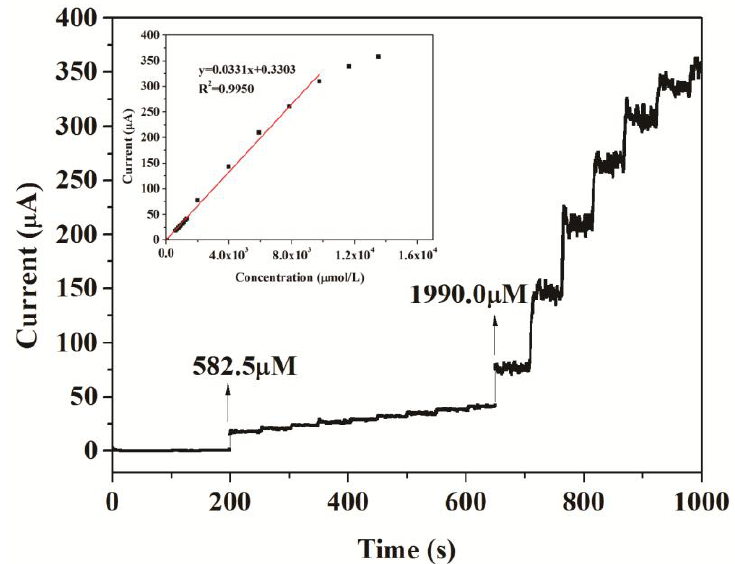
Figure 8. Current-time curve of Cu/CNFs/Lac/Nafion/GCE with successive addition of catechol in 0.10 M, pH 6.0, acetate buffer solutions at operating potential of +0.5 V( vs . Ag/AgCl). Inset: calibration plot illustrating the linear electrode response to catechol